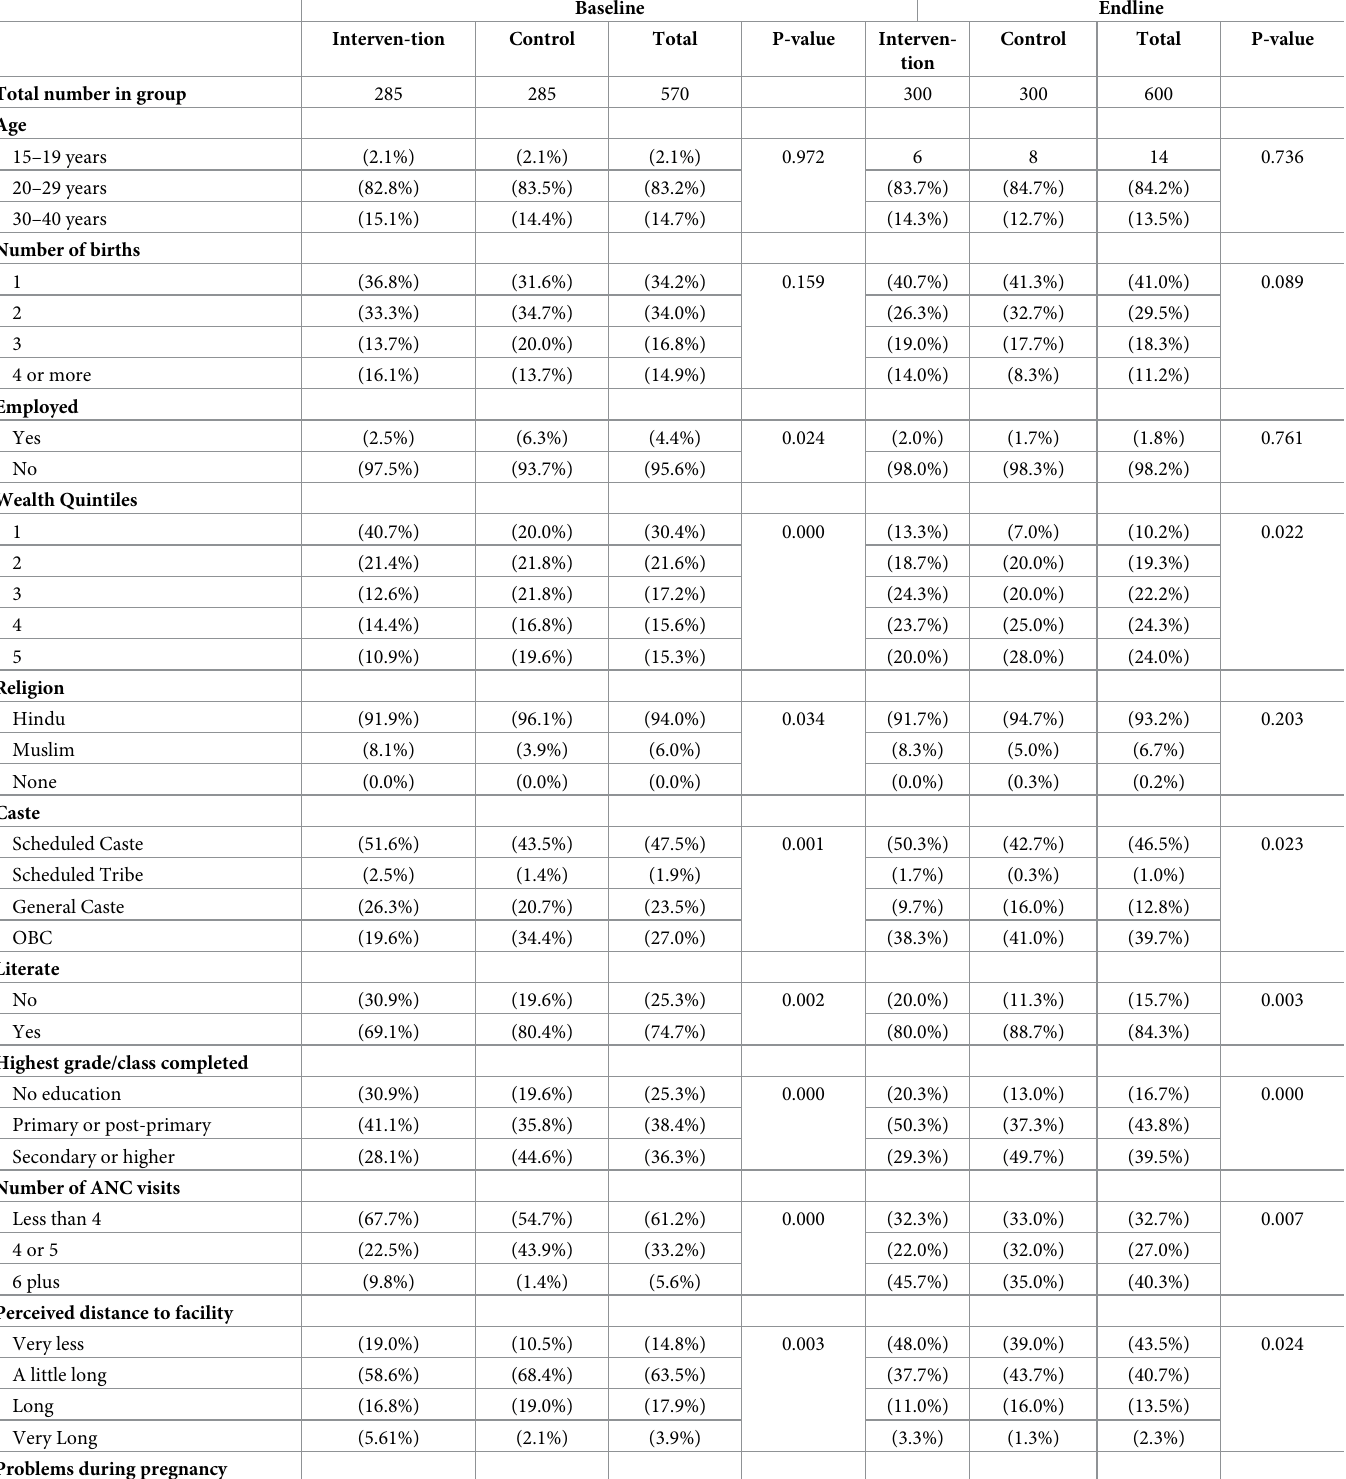
Table 1. Demographic characteristics of study participants across intervention vs. control facilities from baseline to